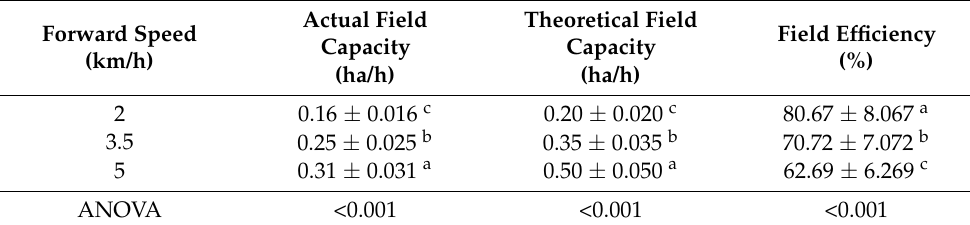
Table 4. Relationship between the different forward speeds on actual field capacity, theoretical field capacity and field efficiency.